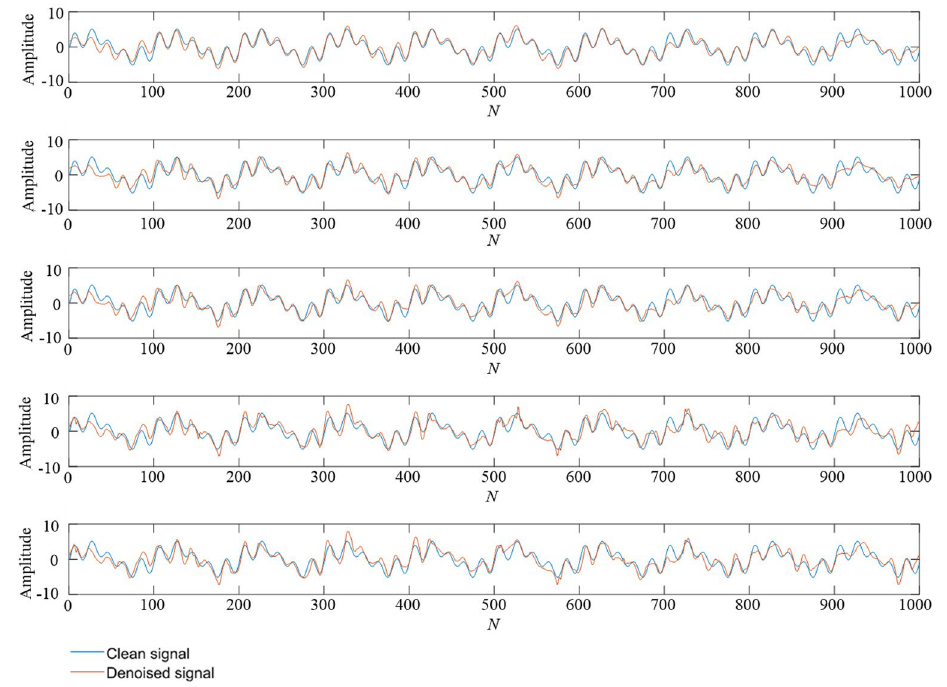
Figure 11. A comparison of denoising effect under -10 dB. From top to bottom: ( 1 ) TS-WOA-VMD-CA-WT; ( 2 ) WOA-VMD-CA-WT; ( 3 ) TS-VMD-CA-WT; ( 4 ) EMD-CA-WT; ( 5 ) EEMD-CA-WT.